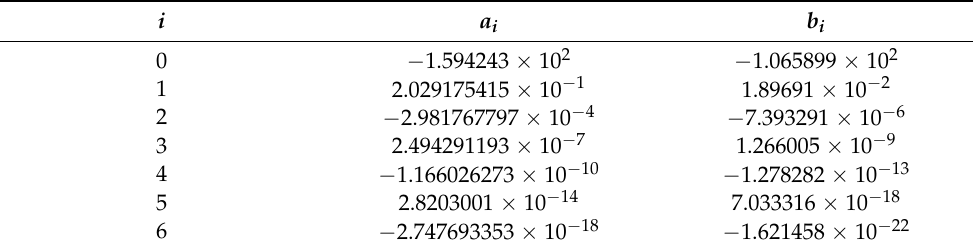
Table 2. Combustion noise